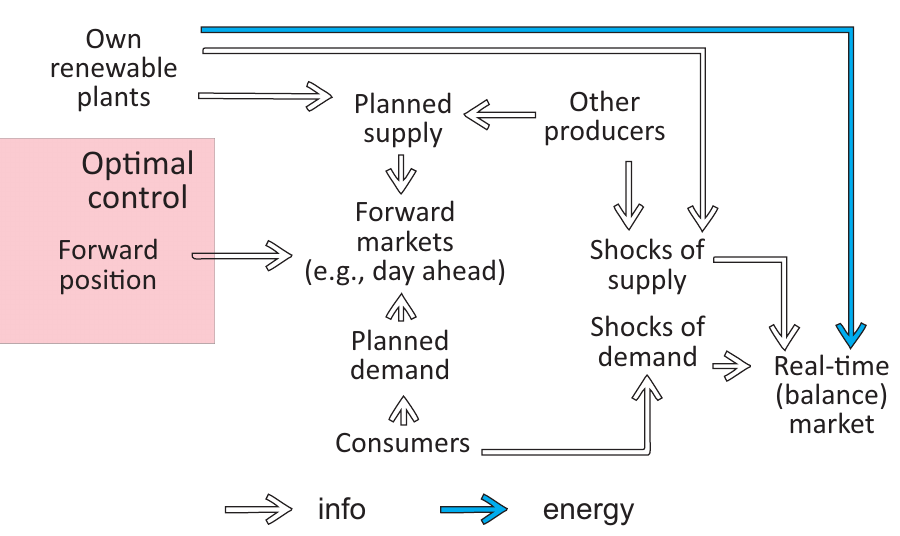
Figure 1. Traditional energy dispatch. White arrows represent flows of information, whereas filled arrows stand for flows of energy. The matching of planned demand with energy supply on the forward market is not depicted.